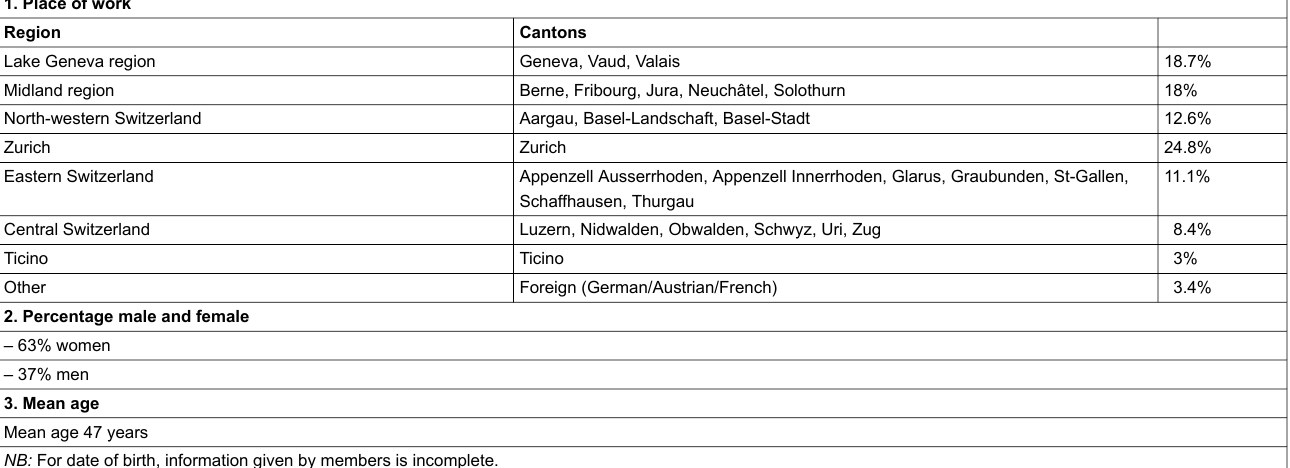
Table S3: Characteristics of the members of the Swiss Society of Gynaecology and